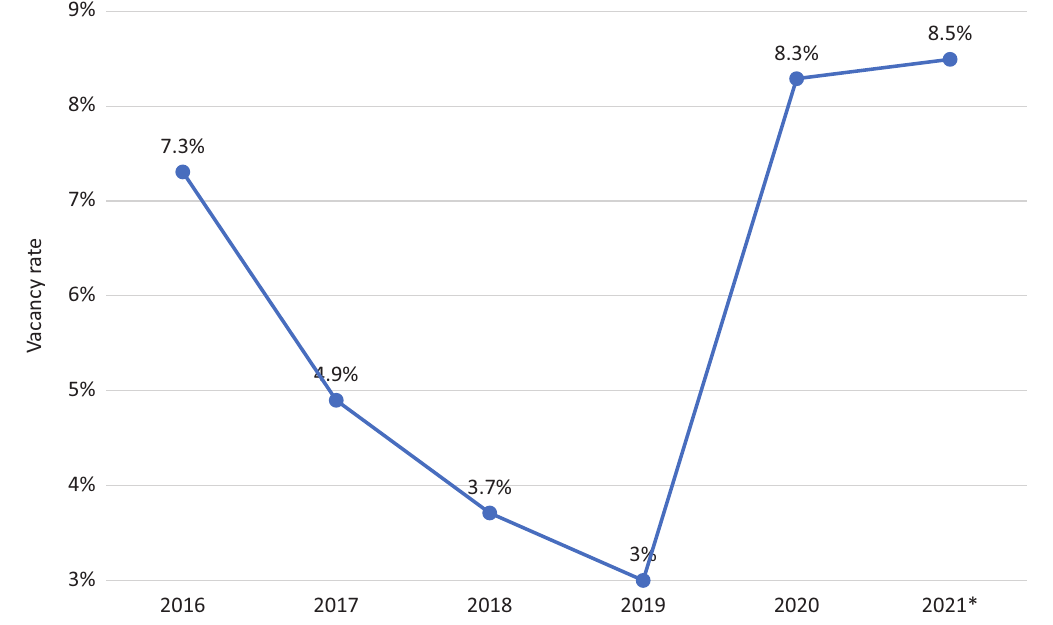
Figure 4. Vacancy rate of the prime office market in Sydney CBD (2016–2021). Source: Statista (2021) using CBRE estimates from